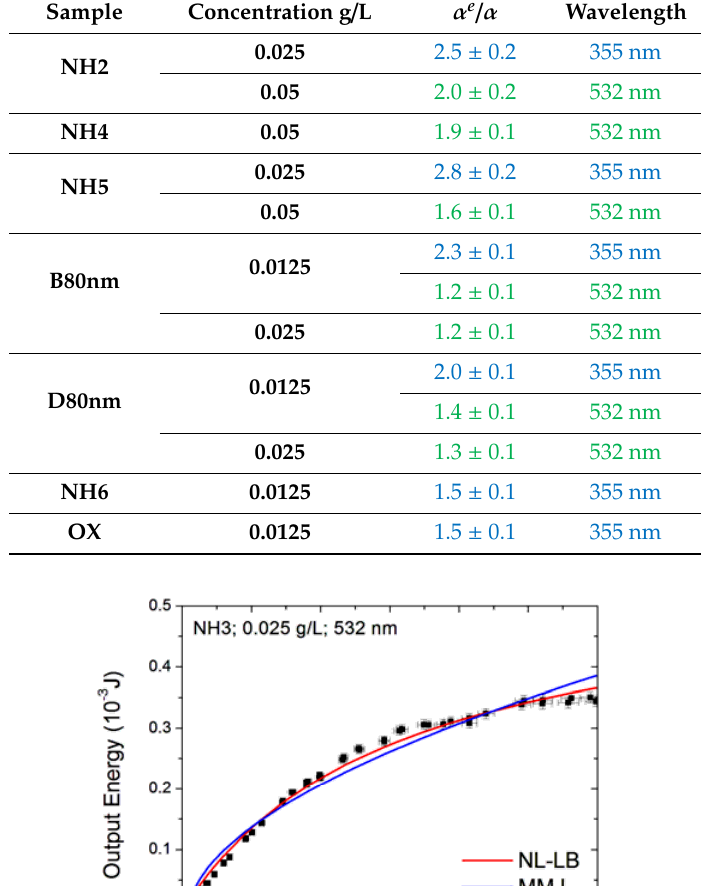
Table 5. Ratio of nonlinear-to-linear extinction coe ffi cients from MMJ model fitting.